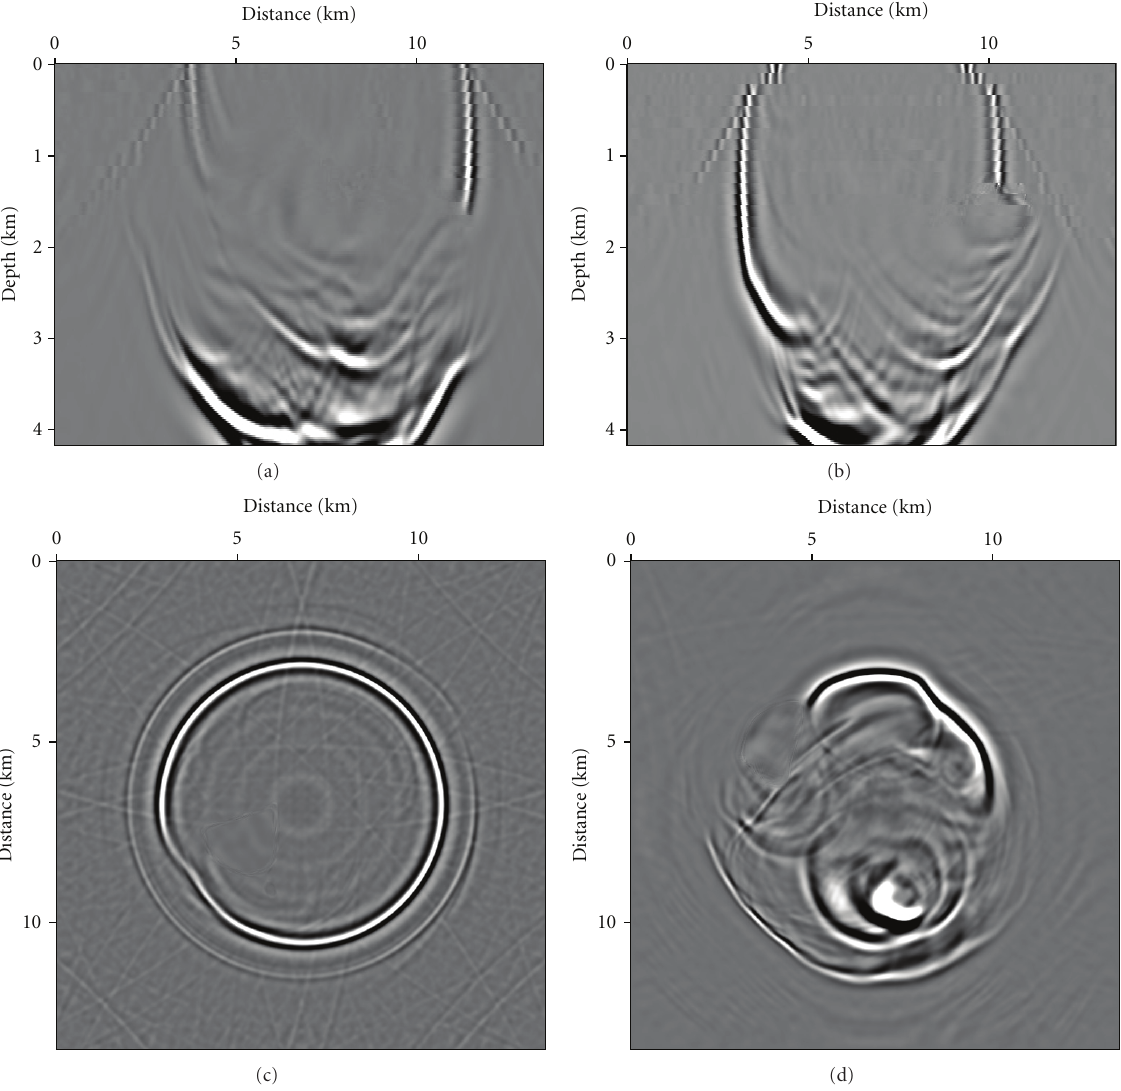
Figure 7: Impulse response obtained by FD migration using the complex Pad´e approximation with 2 terms with rotation angle of 25 ◦ and Li correction (cross-sections as